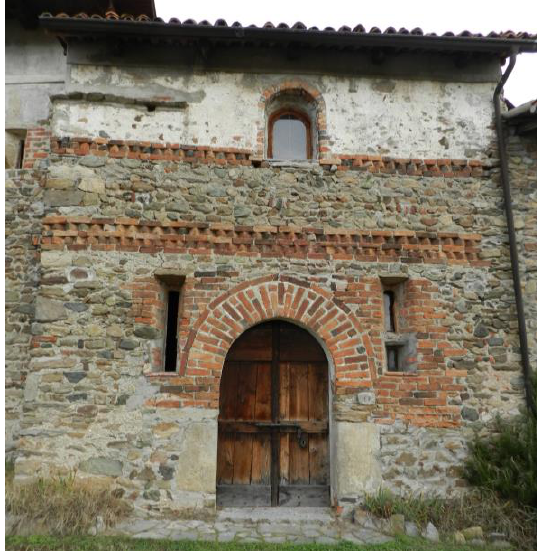
Figure 5. Brick decorative elements (credits Manuela Mattone).